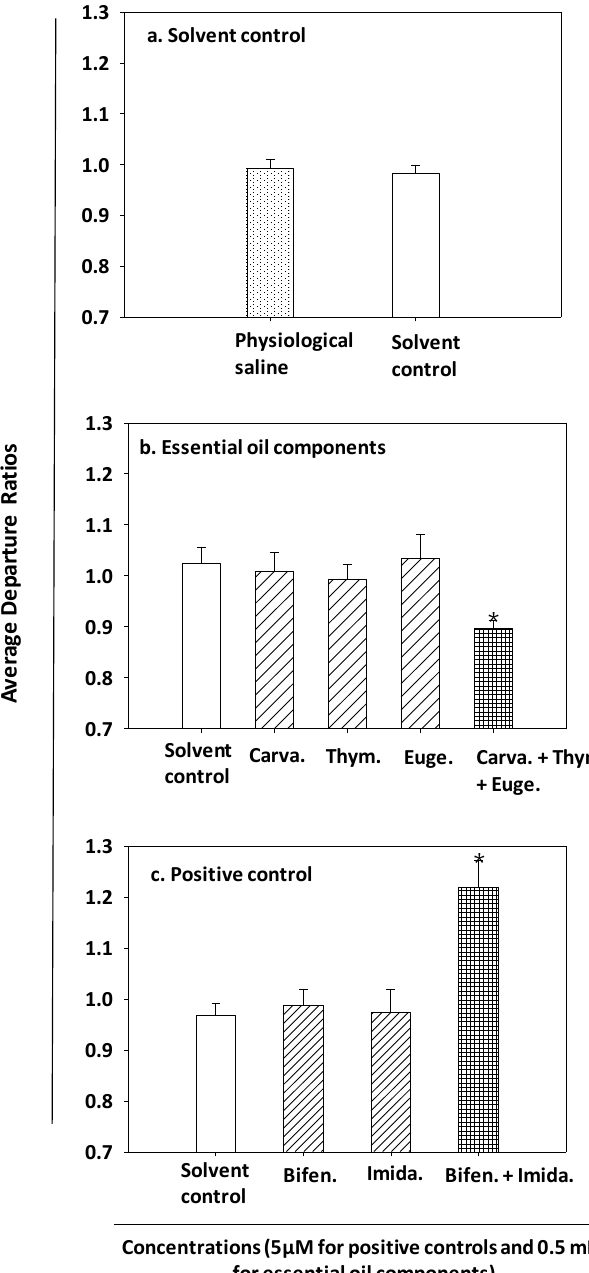
Figure 2. Neurophysiological effects of solvent control, essential oil constituents and positive control treatments on bed bug nervous system activity. Asterisks (*) in different graphs indicate significant differences compared to the solvent control recordings (two-sample t-tests with Bonferroni’ corrected p -value, i.e., 0.05 ÷ number of comparisons for each compound or mixture). ( a ) Solvent controls containing 0.1% dimethyl sulfoxide (DMSO) and 0.01% Tween 20 had no effect on nervous system activity ( p > 0.05). ( b ) The essential oil component mixture of carvacrol (carva.), thymol (thym.) and eugenol (euge.) at 0.5 mM induced higher neuroinhibitory impacts than any of the individual compounds compared to the solvent control ( p < 0.0125). ( c ) The positive control treatment mixture of bifenthrin (bifen.) and imidacloprid (imida.) at 5 µM induced significantly greater neuroexcitatory effects than either of the individual compounds in comparison to the solvent control ( p < 0.016).